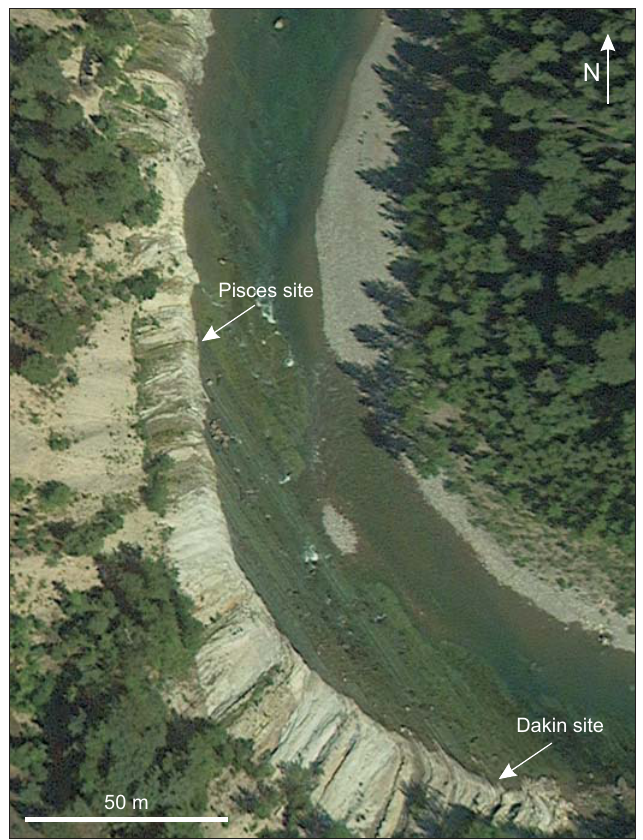
Fig. 2. Photograph of the Kishenehn Formation (Coal Creek Member) Da- kin and Pisces sites. The beds (parallel ridges) can be traced beneath water level to connect the two sites. Map data ©2014 Google.